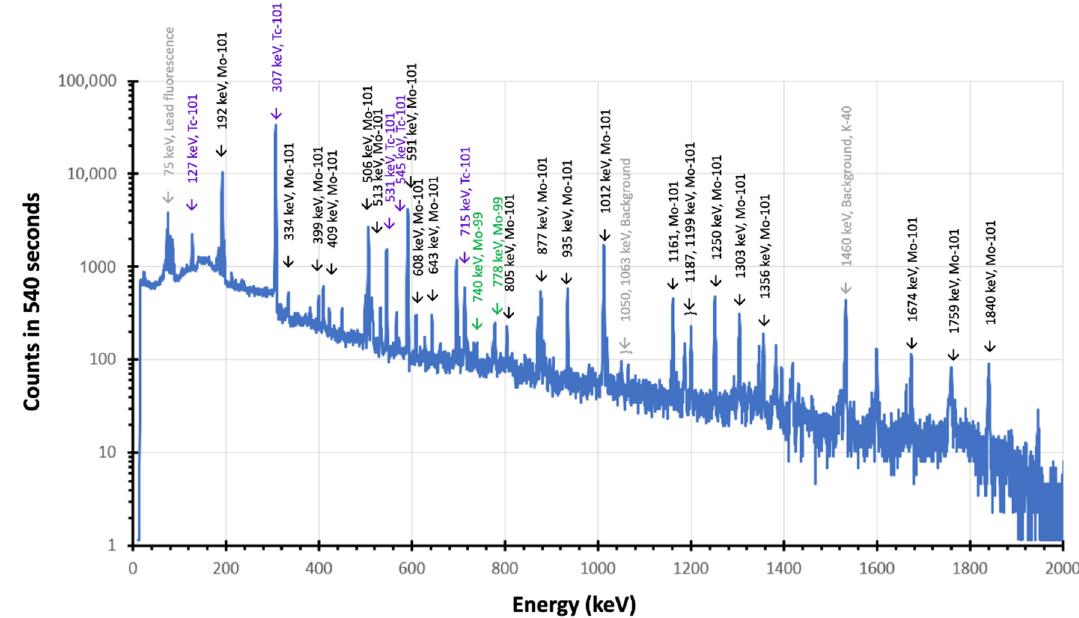
Figure 2. Characteristic peaks for 99 Mo are shown in green, 101 Mo in black, and 101 Tc in purple. Peaks attributed from background contribution are shown in grey.